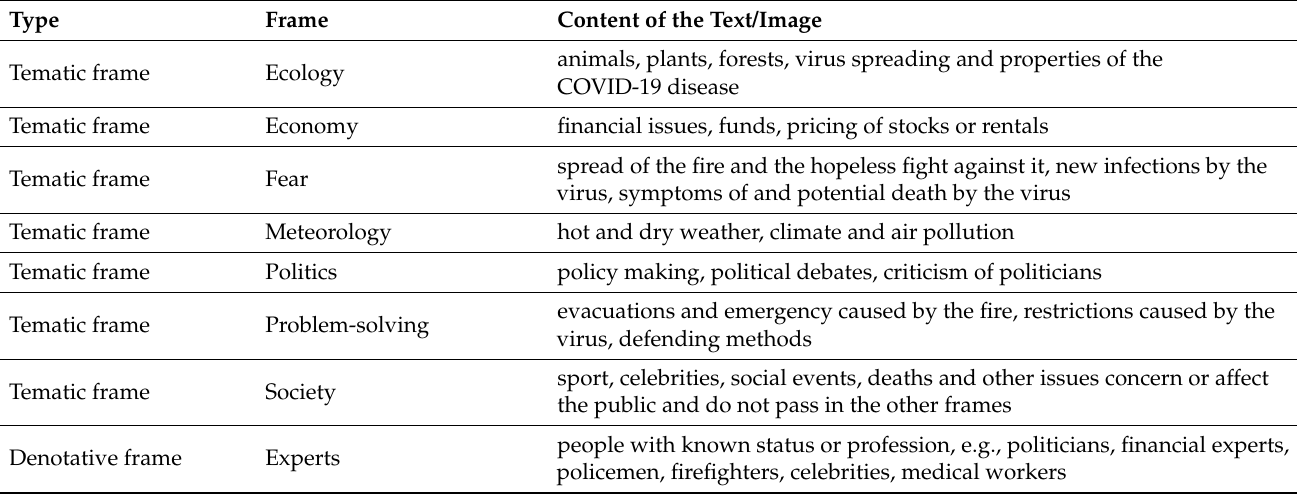
Table A1. Meaning of the applied Thematic, Denotative and Connotative